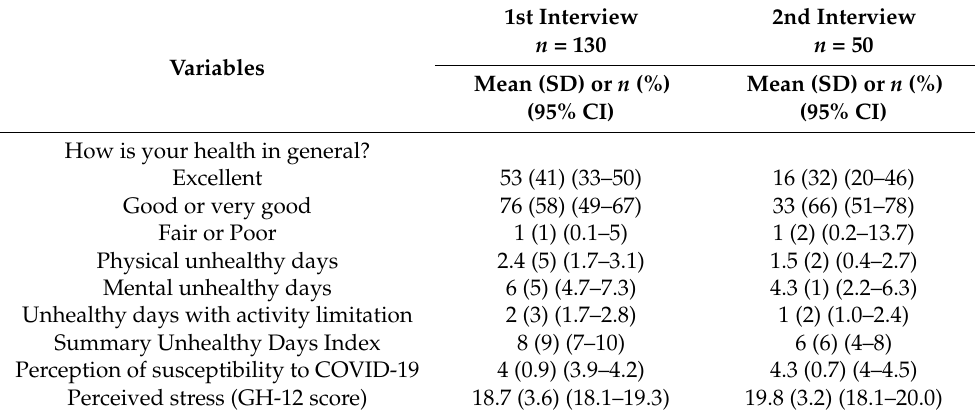
Table 2. Quality of life, perception of susceptibility to COVID-19, perceived stress by time.